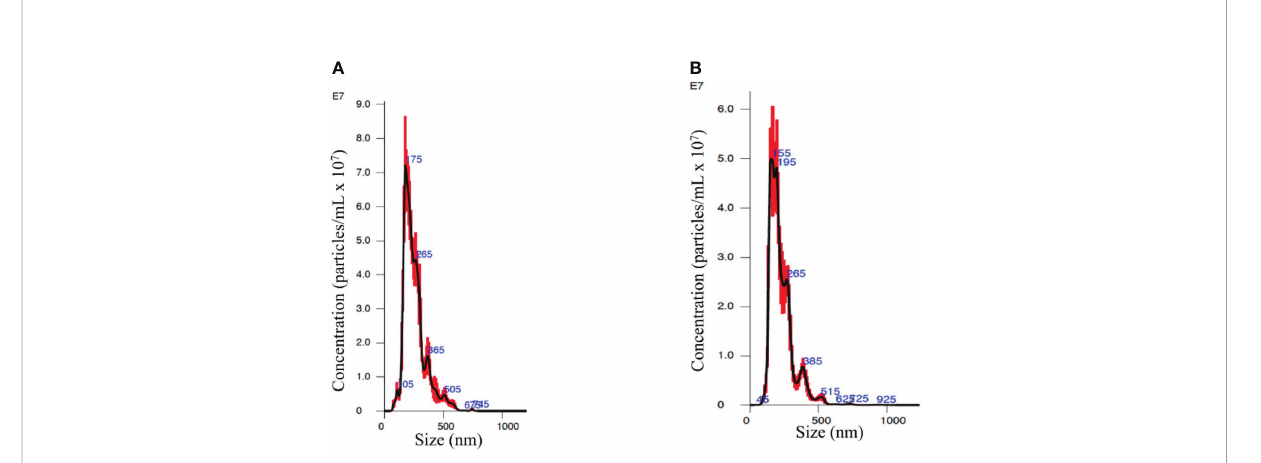
FIGURE 1 Nanosight analysis of the extracellular vesicles (EVs) from an organ-con fi ned (OC) patient (A) and a healthy subject (B) showing similar spectrums of vesicle size and